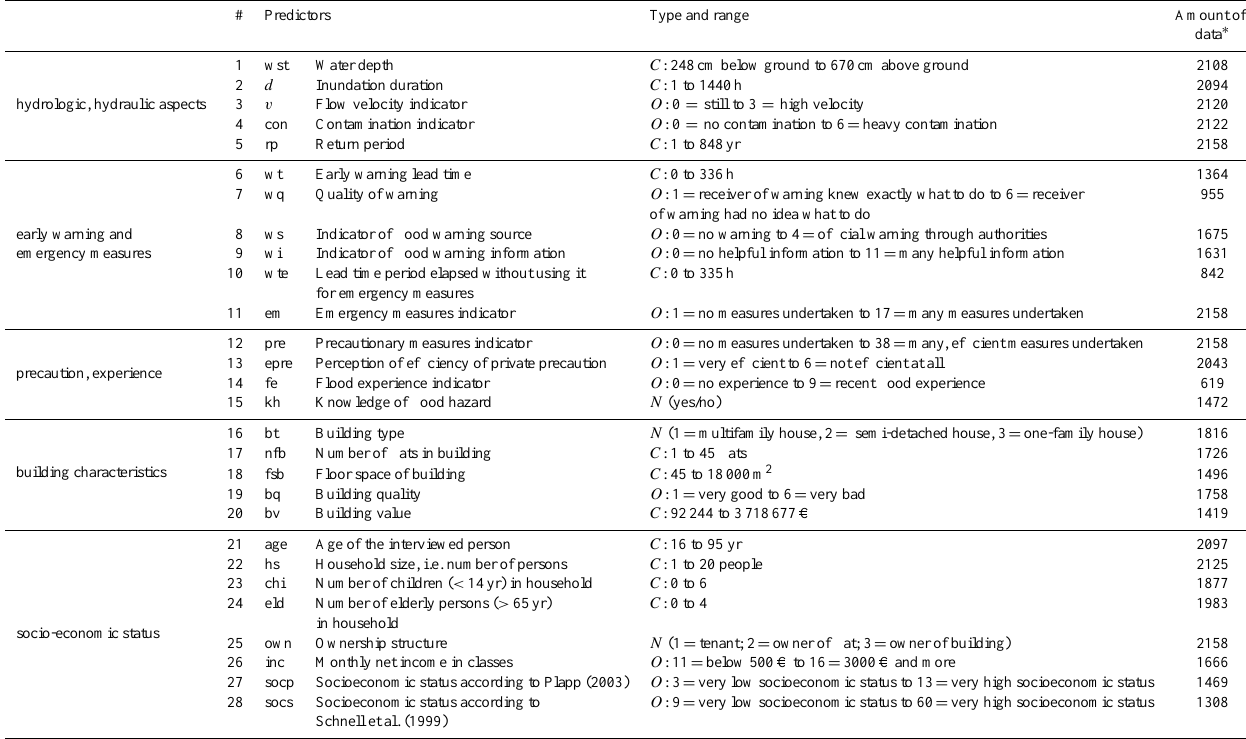
Table 1. Description of the 28 candidate predictors ( C : continuous, O : ordinal, N : nominal).